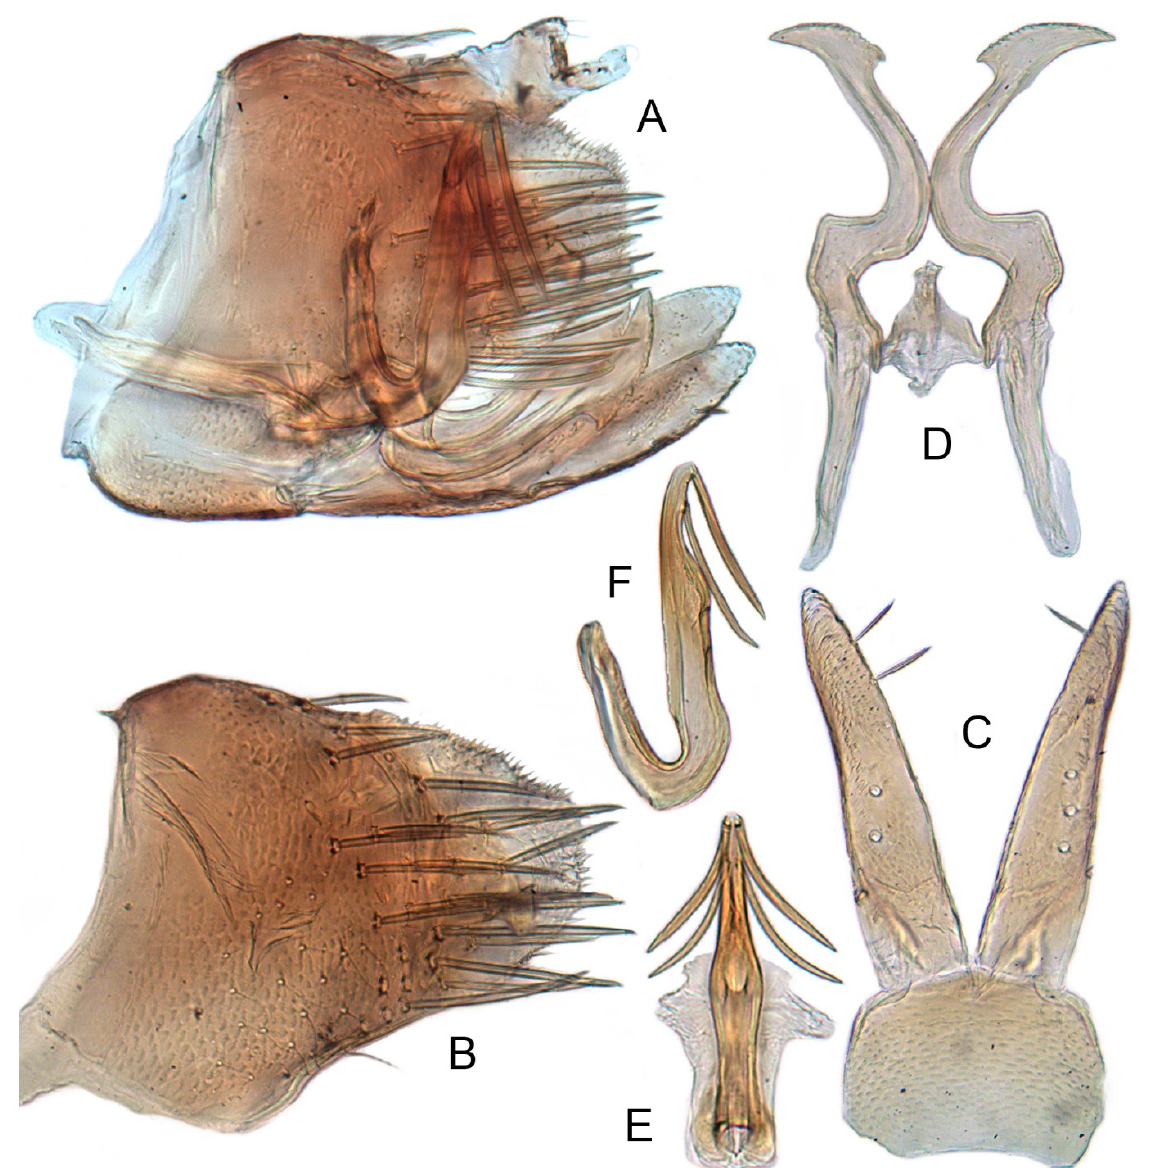
Figure 15. Xestocephalus exproiecturus sp. nov. ( A ) Male genital capsule, lateral view; ( B ) pygofer lobe; ( C ) subgenital plates and valve, ventral view; ( D ) style and connective, ventral view; ( E ) aedeagus, posterior view; ( F ) aedeagus, lateral view.